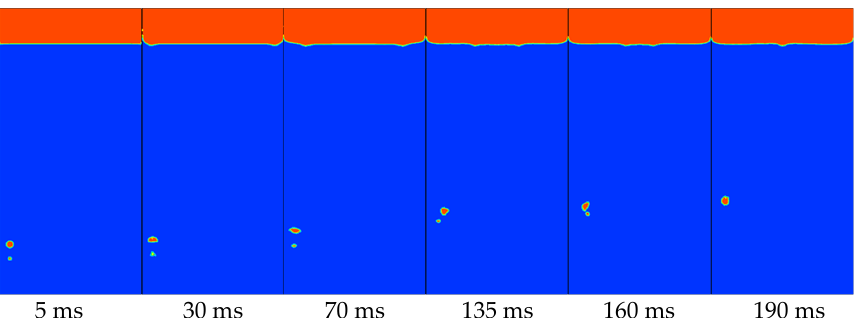
Figure 15. The rising shape of double bubbles of different sizes near the wall (upper large and lower small).